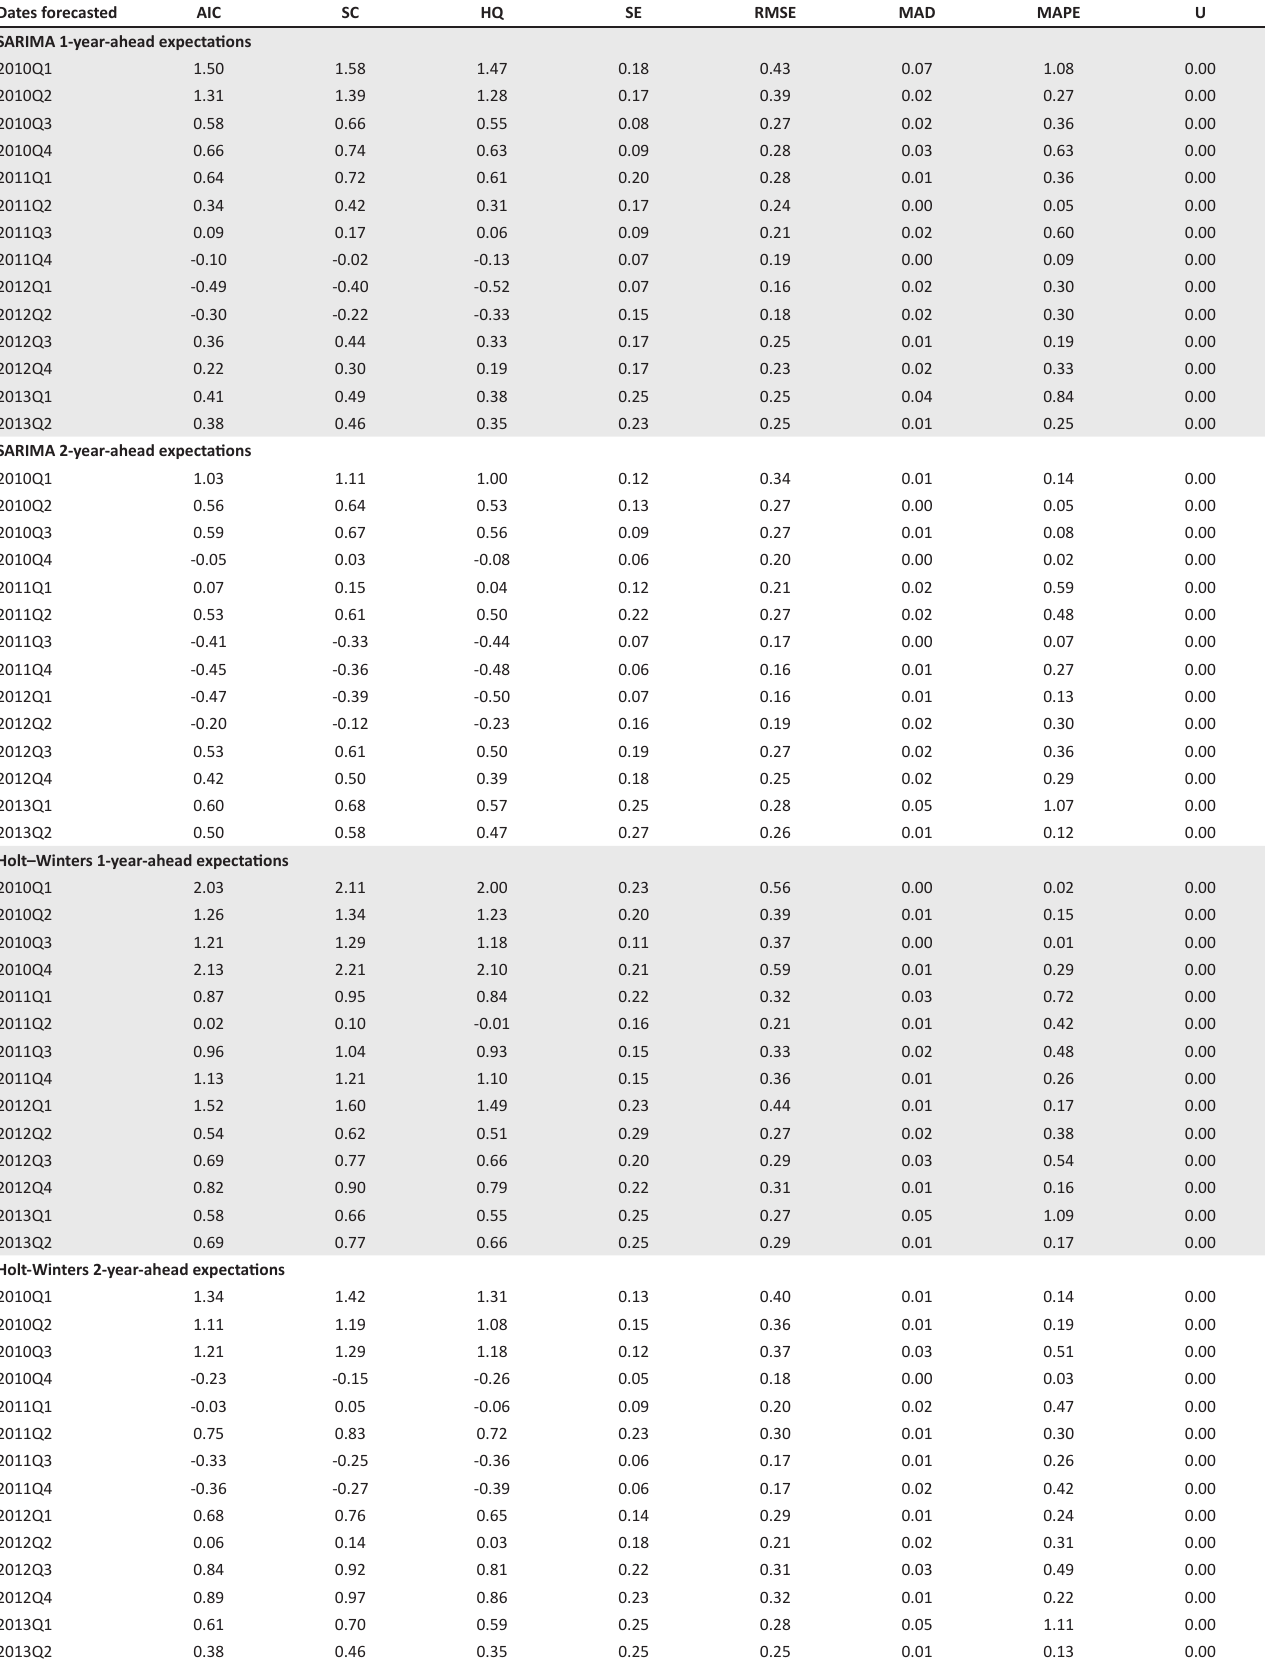
TABLE 2-A1: Inflation accuracy comparison with Bureau for Economic Research and South African Reserve Bank – Quarterly approach. Dates forecasted AIC SC HQ SE RMSE MAD MAPE